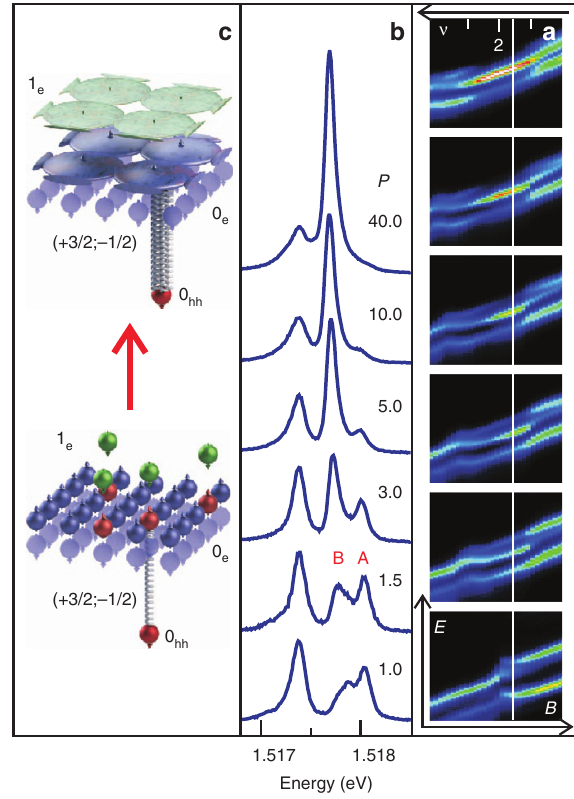
Figure 3 | Photoinduced emission—temperature dependence. Emission spectra corresponding to radiative recombination of electrons below the Fermi level with heavy holes measured in the temperature range T ¼ 0.5–1.5K at fixed photoexcitation power P ¼ 32mWcm (cid:2) 2 . At elevated temperatures a single optical transition in s þ polarization (A) is seen. The B line observed at low temperatures is a CME signature. The bottom diagram demonstrates optical transitions between the single-particle states in two possible polarizations of the emitted photons. The top diagram shows expected optical transitions in s þ polarization in the presence of a CME ensemble.